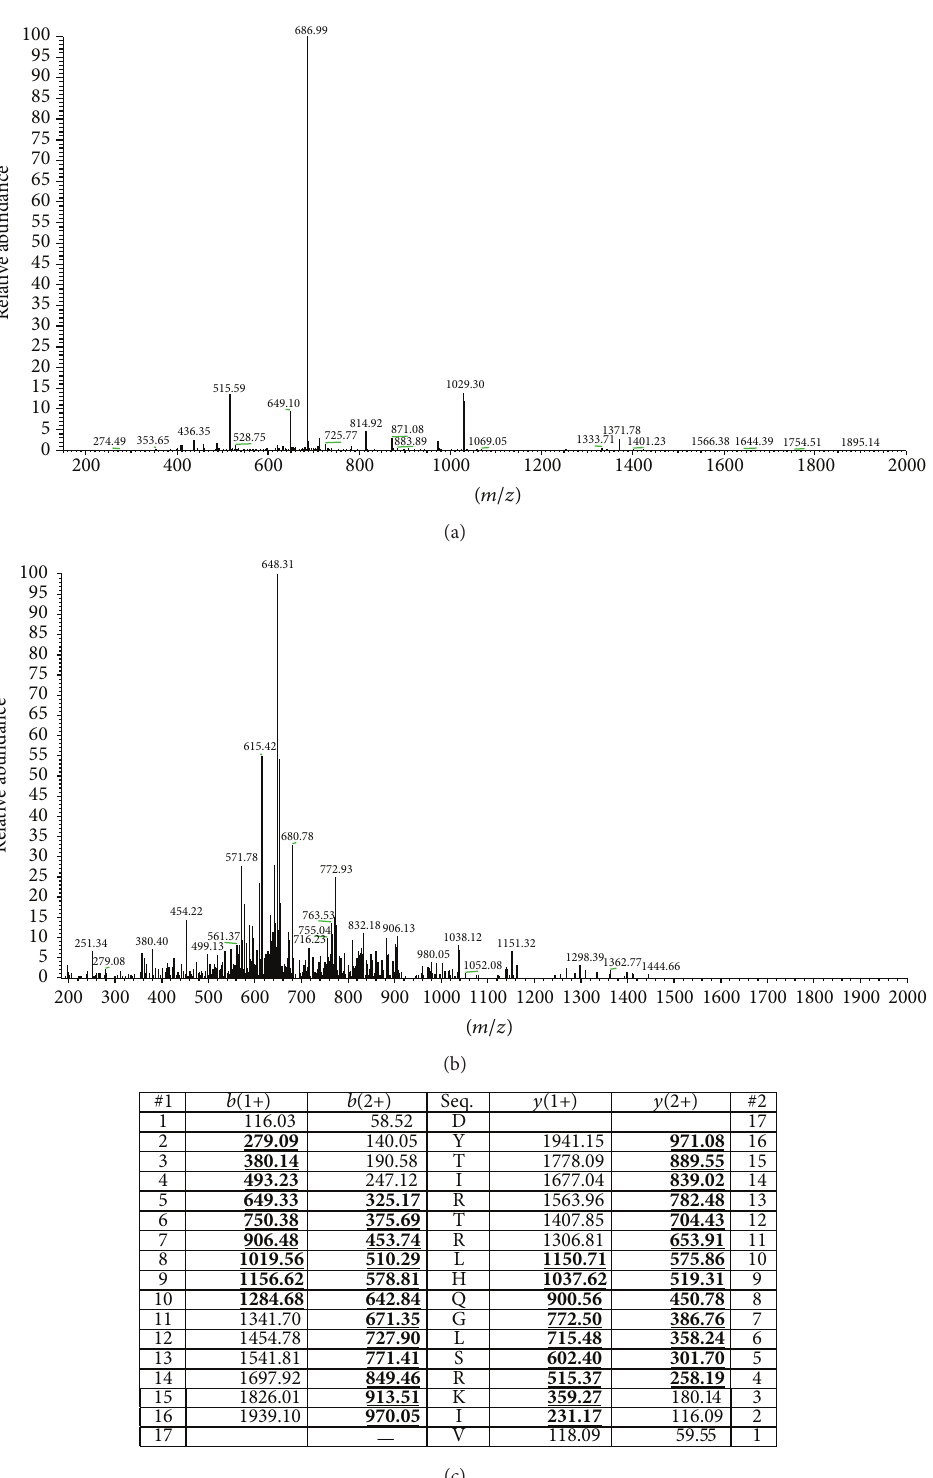
Figure 2: (a) Electrospray MS spectrum of a sample from reverse phase HPLC fraction #100 that contained bradykinin inhibitory activity. The doubly charged ion ( m/z 1029.30), triply charged ion ( m/z 686.99), and quadruply charged ion ( m/z 515.59) of a peptide with a parent mass of 2056.4 Da were detected. (b) MS/MS fragmentation spectrum of the doubly charged ion at m/z 1029.30. (c) Theoretical singly and doubly charged b - and y -ion series arising from MS/MS fragmentation of the bradykinin inhibitory peptide with observed ions indicated in bold typeface and